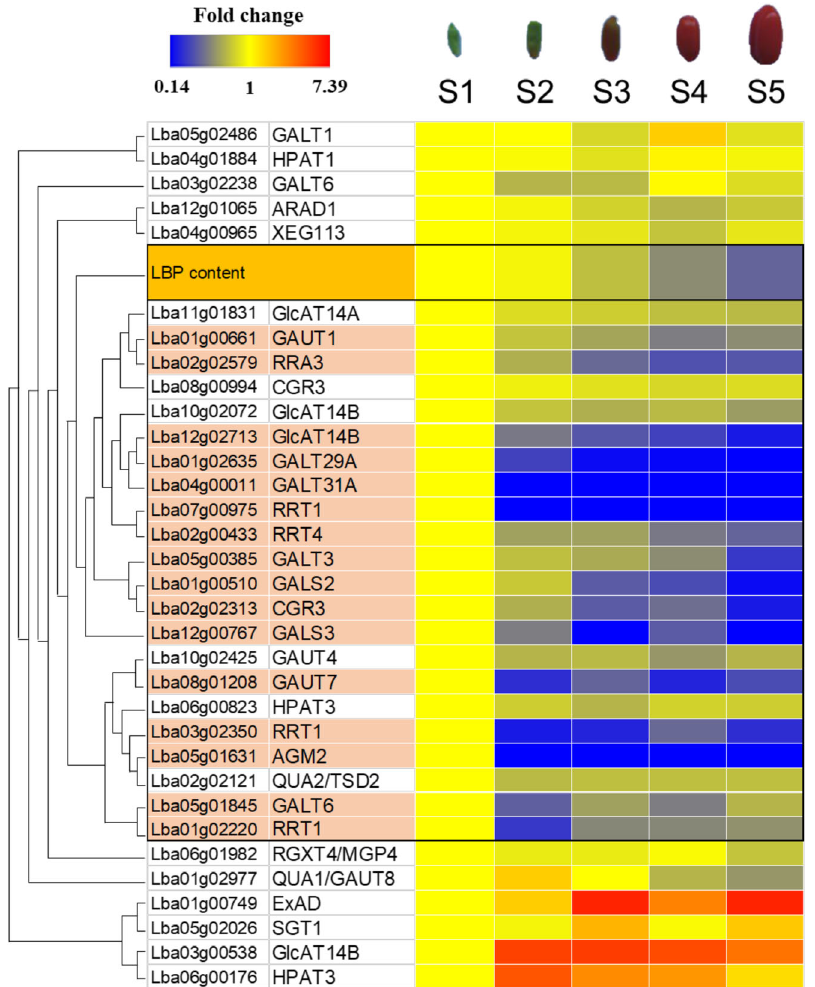
Fig. 3 Heat map of L. barbarum polysaccharide (LBP) and expression of putative genes responsible for LBP biosynthesis during fruit development in Lycium . Fruit development was divided into fi ve stages (S1 – S5), as shown at the top of the fi gure. LBP contents or fragments per kilobase million (FPKM) values of all genes in the S1 stage were set to 1, and the fold changes of LBP contents or FPKM for the other stages (S2 – S5) were calculated. LBP contents and gene expression patterns during fruit development are shown in red (high) – yellow – blue (low) gradation. Only FPKM fold changes >0.5 were considered as downregulation. Genes marked in light orange represent candidate genes for LBP biosynthesis. The localization of these gene products and the relationship of GTases with LBP structures are indicated in Supplementary Fig. 26. S1: young stage, 9 days post anthesis; S2: green stage, 15 days post anthesis; S3: turning stage, 21 days post anthesis; S4: red stage, 28 days post anthesis; S5: ripe stage, 35 days post